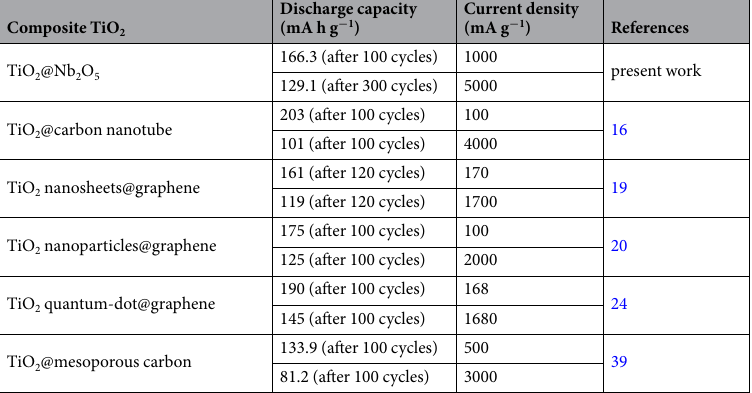
Composite TiO 2